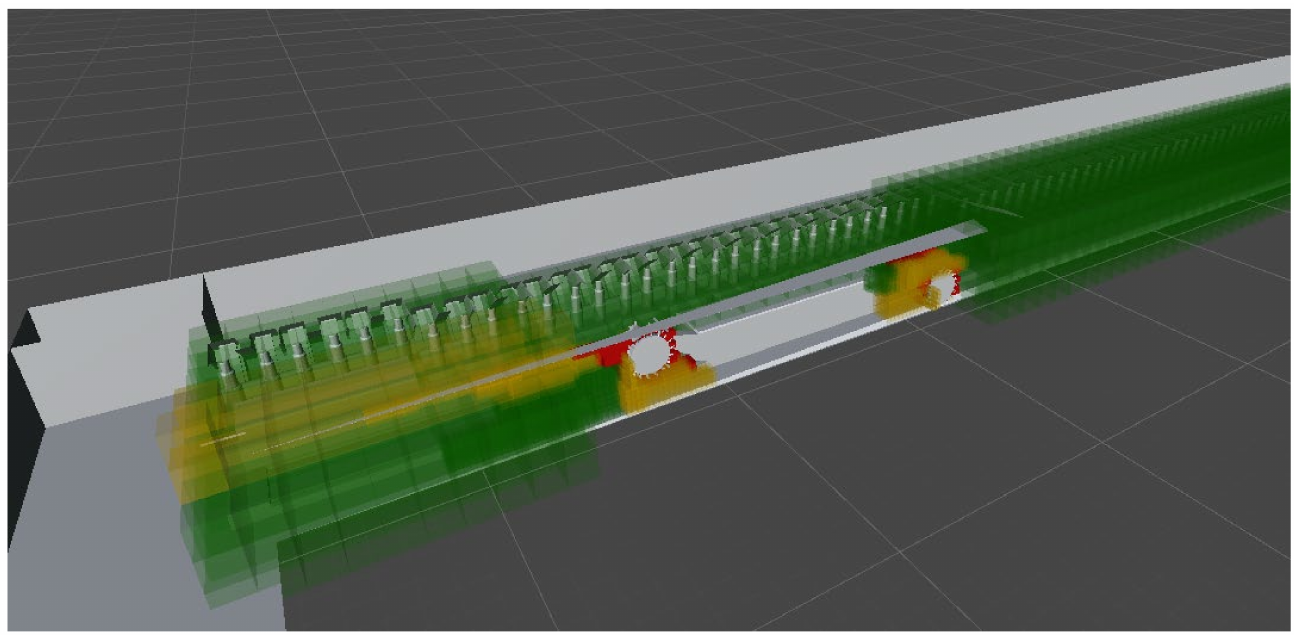
Figure 3. Snapshot of the 120th second of shearer location